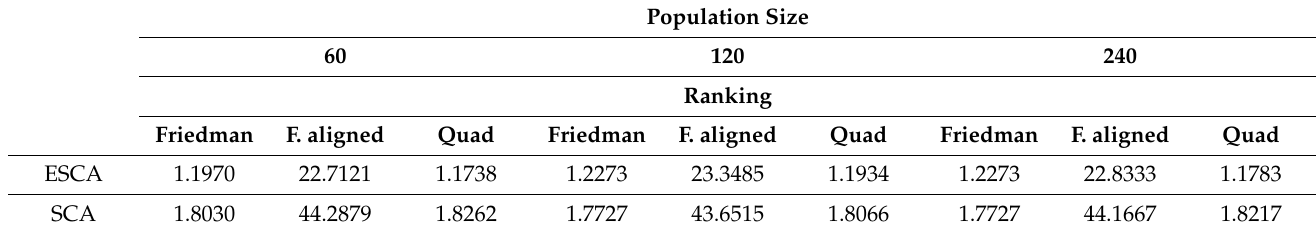
Table 16. Comparison of solution accuracy for ESCA and SCA algorithms. The average ranking results by Friedman, Friedman aligned, and Quade tests.